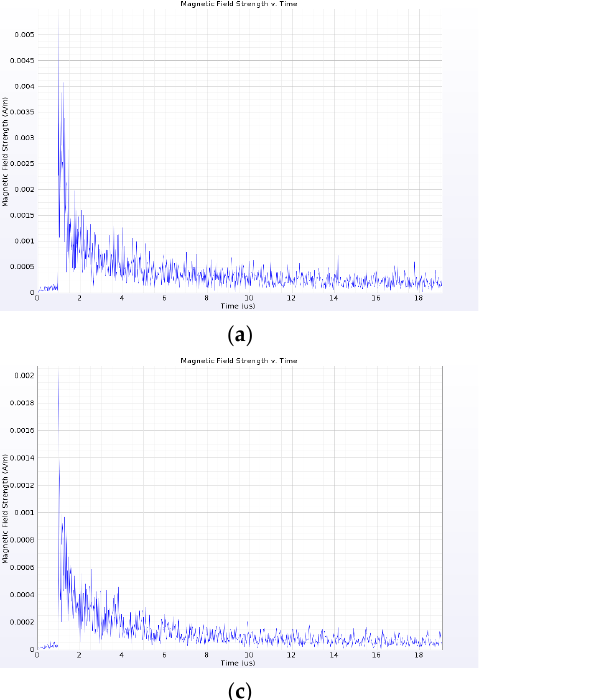
( d ) Figure 9. Effect of insulator on near - field propagation characteristics of PD electromagnetic wave signal. ( a ) Electric field strength at point sensor 1; ( b ) Electric field strength at point sensor 2; ( c ) Electric field strength at point sensor 3; ( d ) Electric field strength at point sensor 4.